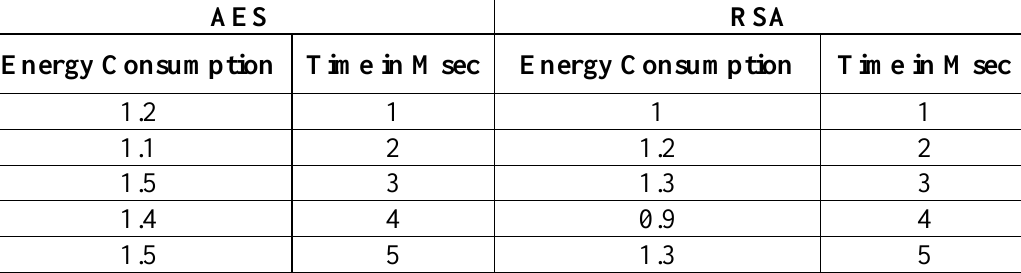
Table 8. Energy Consumption Time of AES and